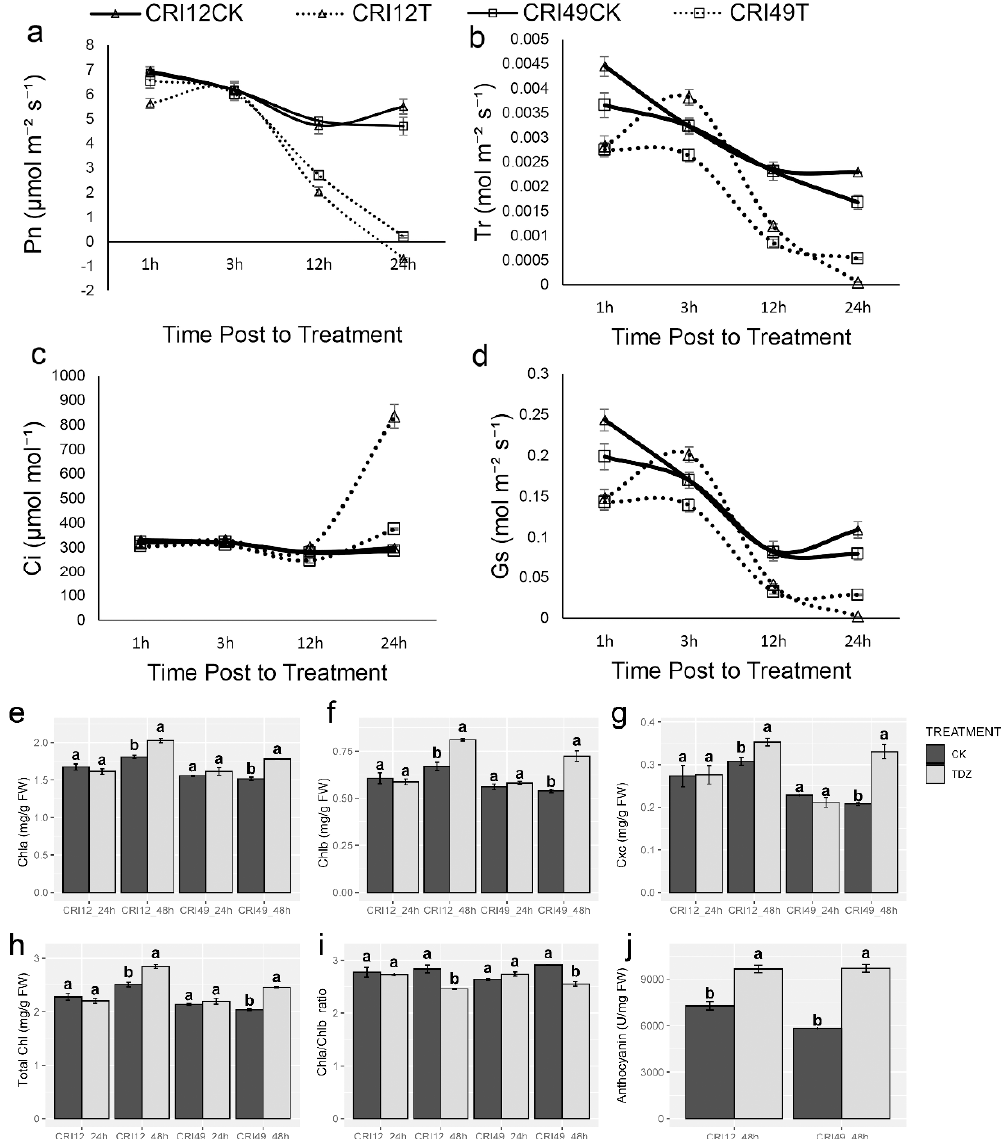
Figure 3. Photosynthetic parameters changes under TDZ treatment. ( a ) Net photosynthetic rate; ( b ) Transpiration rate; ( c ) Intercellular carbon dioxide concentration; ( d ) Stomatal conductance; ( e ) The content of chlorophyll a; ( f ) The content of chlorophyll b; ( g ) The content of carotenoid; ( h ) The content of total chlorophyll; ( i ) The ratio of chlorophyll a and chlorophyll b; ( j ) The content of anthocyanin. CRI12CK, CRI12T, CRI49CK, and CRI49T represent CK and TDZ treatment of CRI 12, and CRI 49, respectively. Values not sharing a common letter within the same column are significantly different ( p < 0.05) according to Duncan’s test using SAS software.